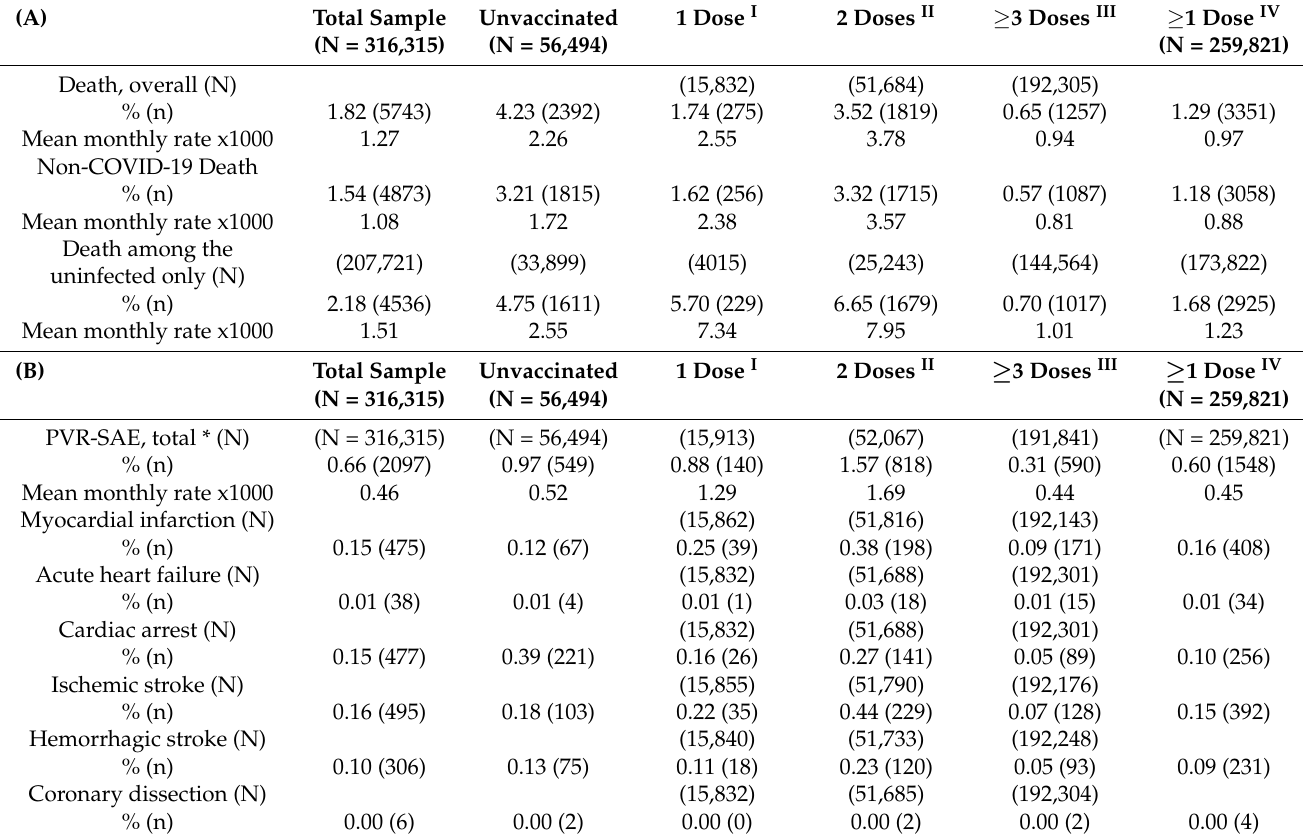
Table 2. Main outcomes * by COVID-19 vaccine status. (A) All-cause death and non-COVID-19 death by vaccine status. (B) Potentially vaccine-related serious adverse events (PVR-SAEs) by vaccine